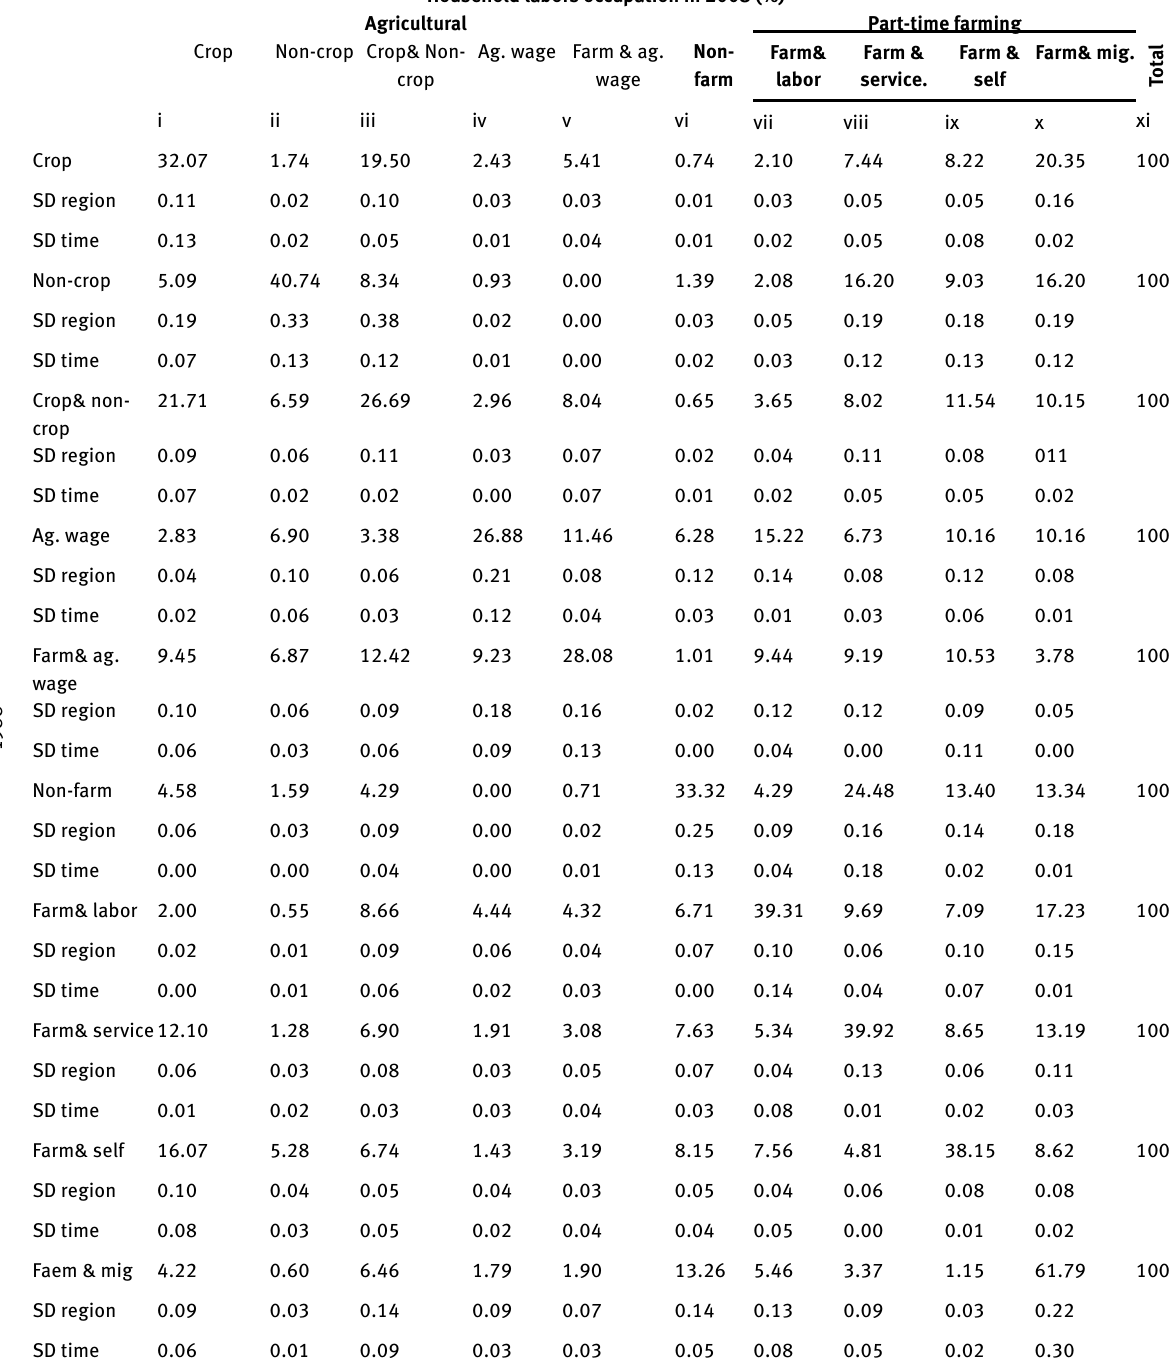
Table 2: Average transition probabilities and standard deviations across regions & time of rural households